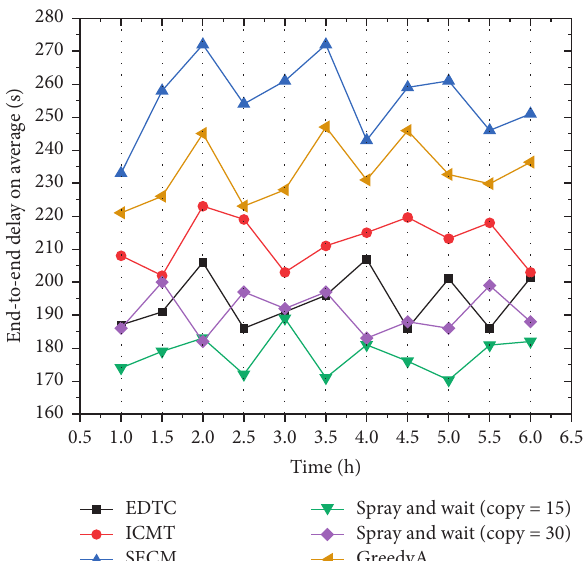
Figure 16: Relationship between delivery ratio and cache.